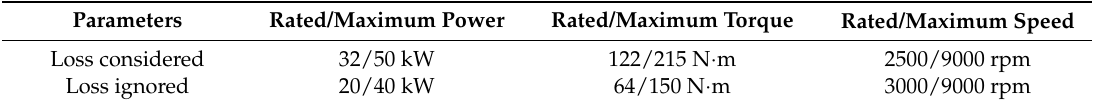
Table 2. Motor Parameters Comparison.